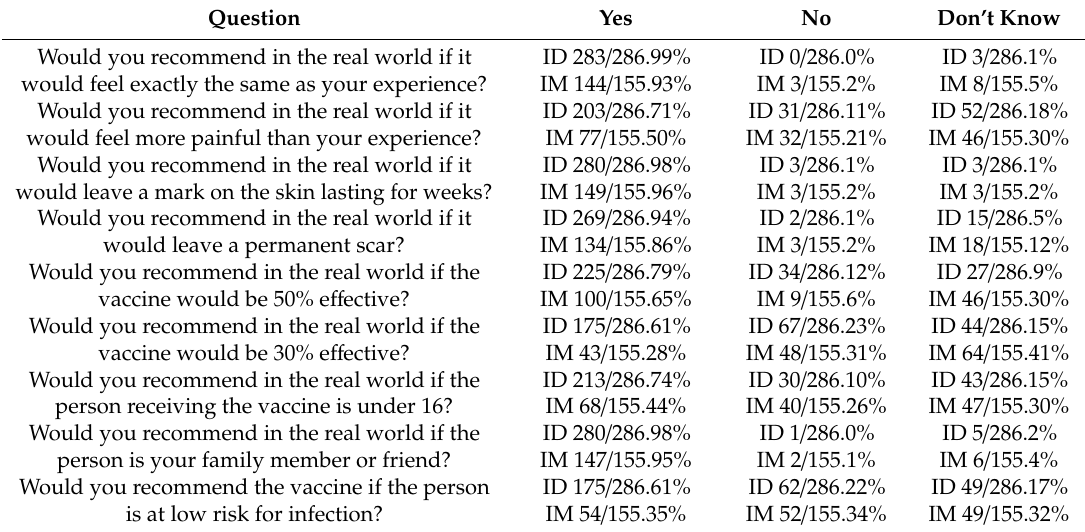
Table 3. Participant willingness to recommend electroporation (EP) vaccination to others, for an e ff ective HIV vaccine, under specific circumstances. Responses from two weeks after each injection and six months after final injection,